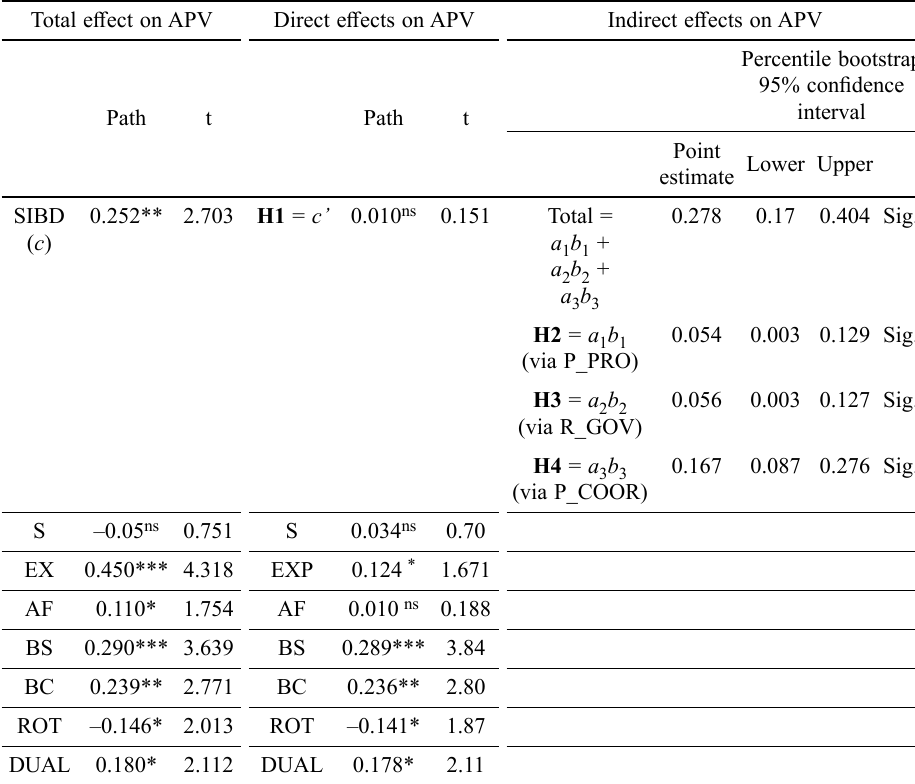
Table 4. Summary of mediating effect